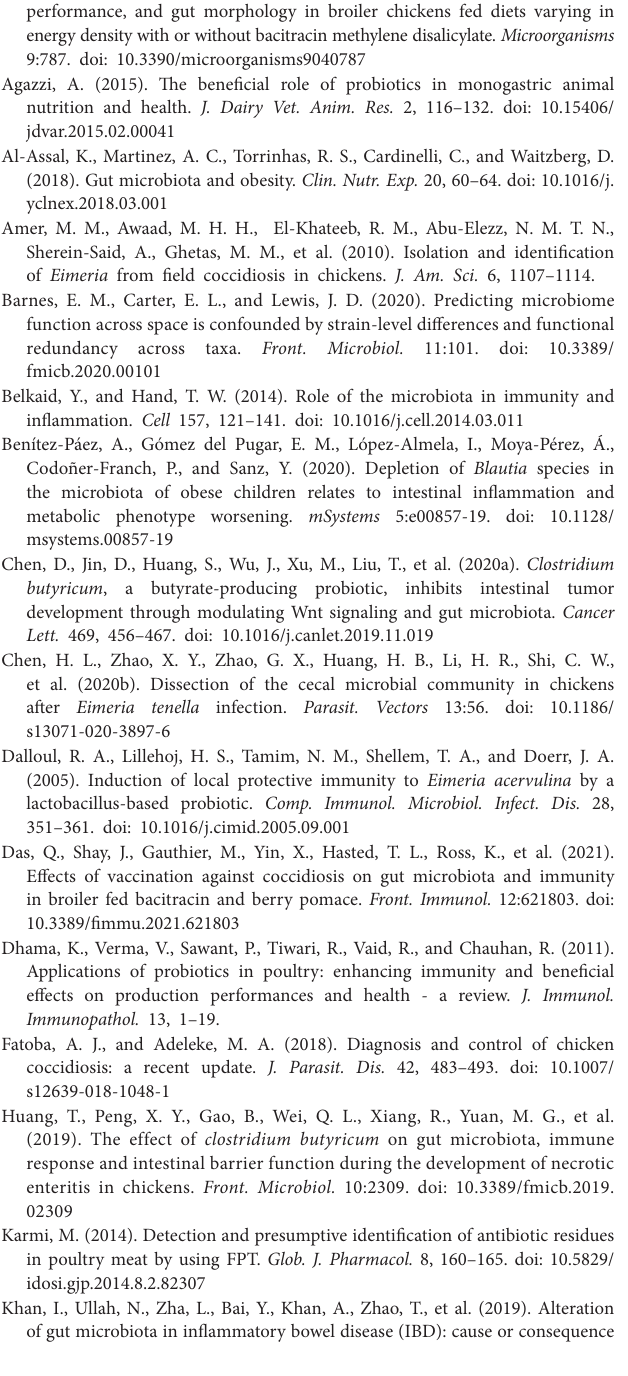
Supplementary Figure S5 | Correlation heatmap for the intestine microbiome from samples pretreated with Clostridium butyricum and coccidiosis vaccine and then challenged with Eimeria sp. Correlation heatmap shows sample similarity by clustering the samples with similar taxa. Yellow indicates a close correlation, while green indicates a more distant correlation in the data. The heatmap was produced using the heatmap.2 function from gplots package in R version